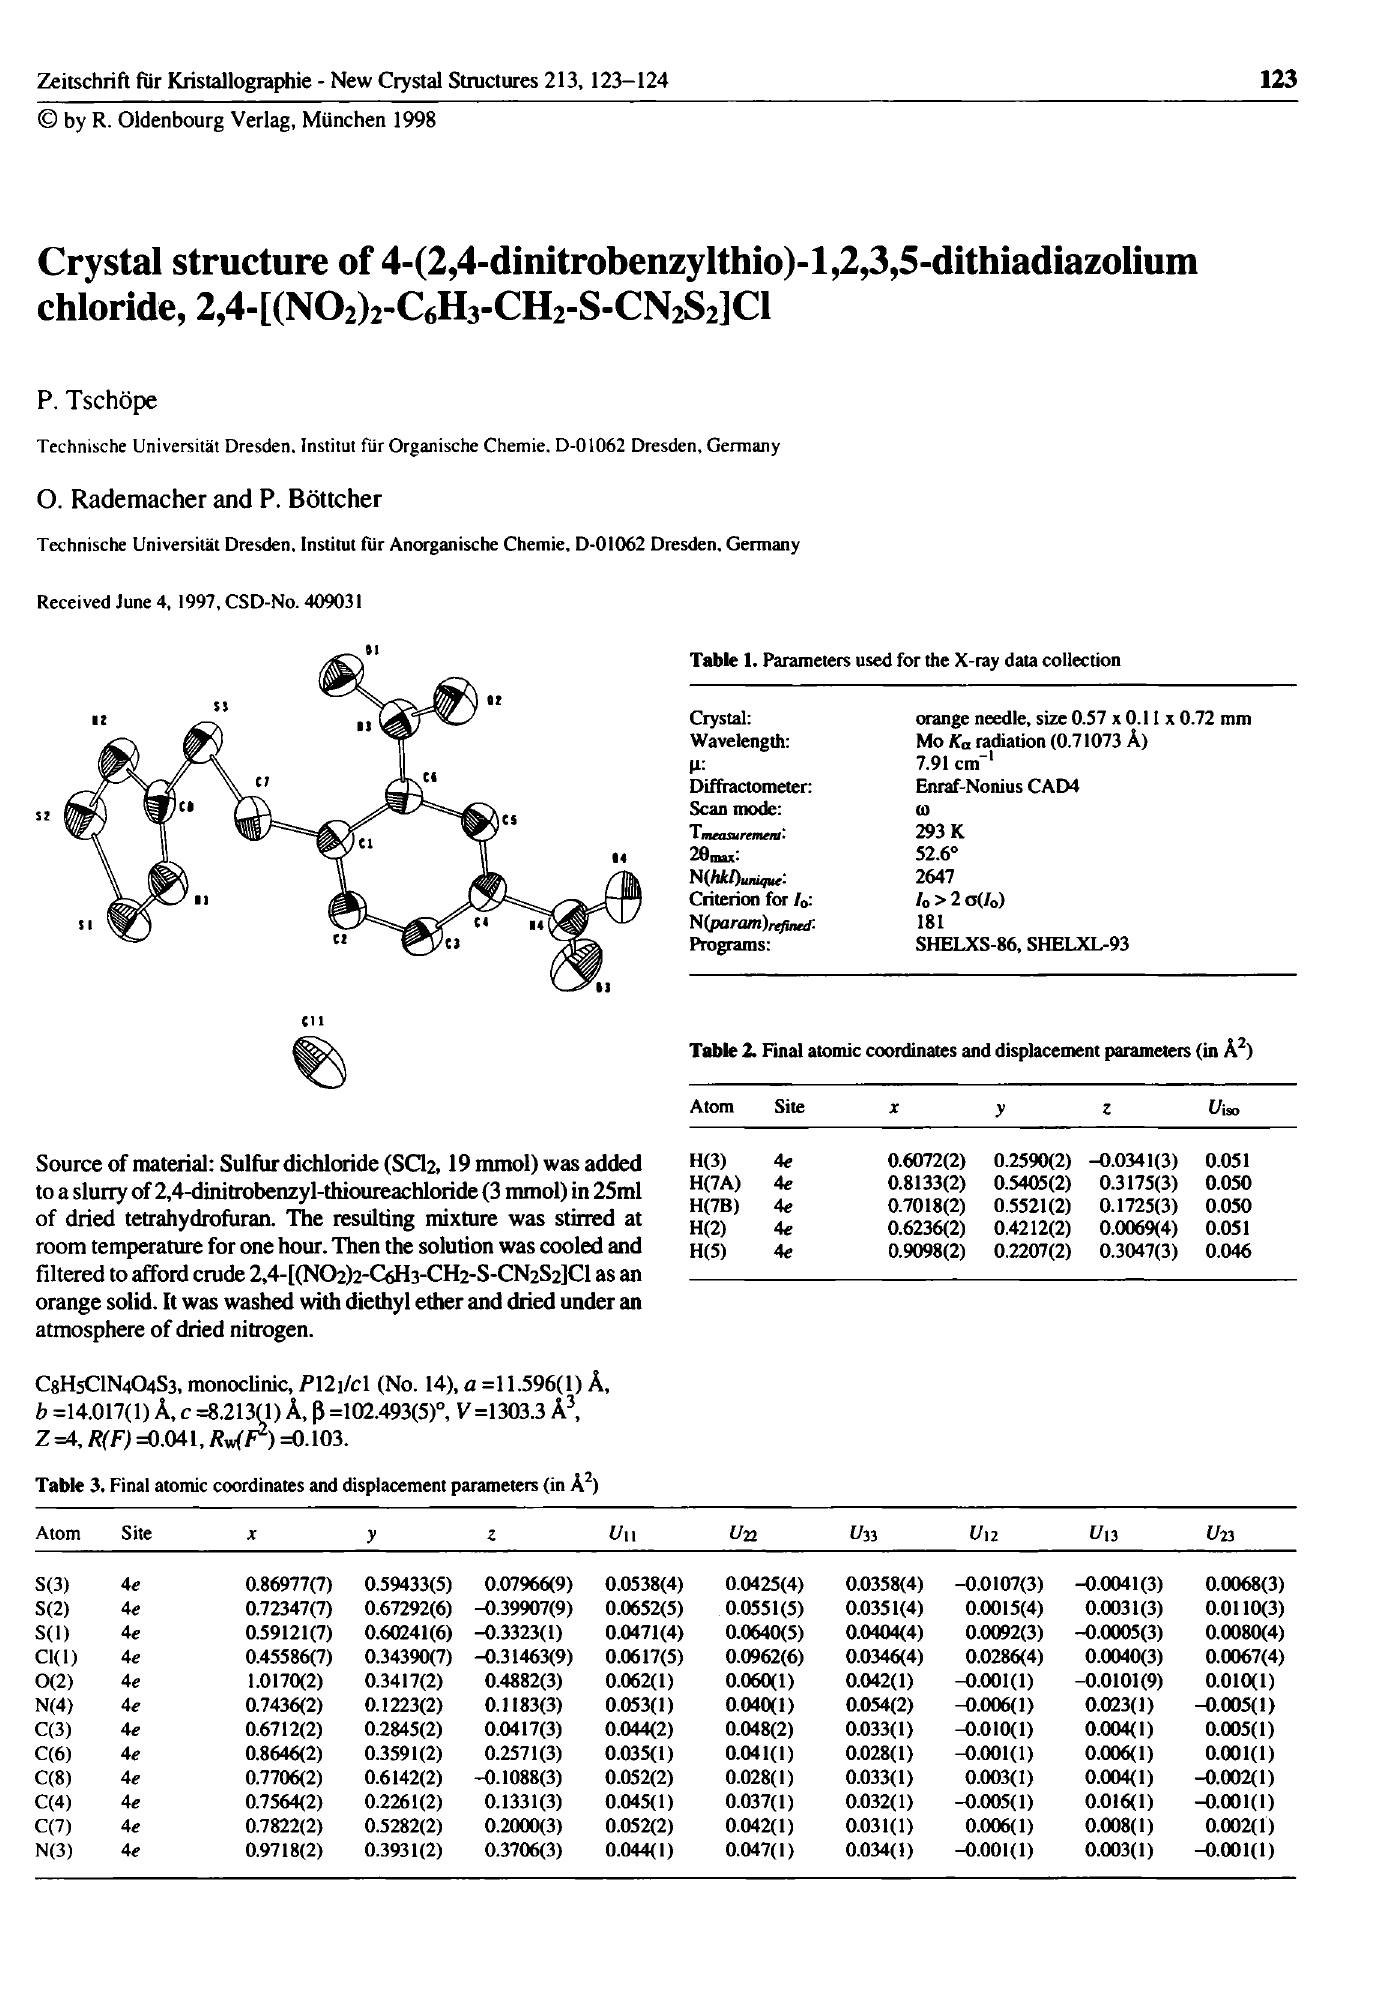
Table 3. Final atomic coordinates and displacement parameters (in